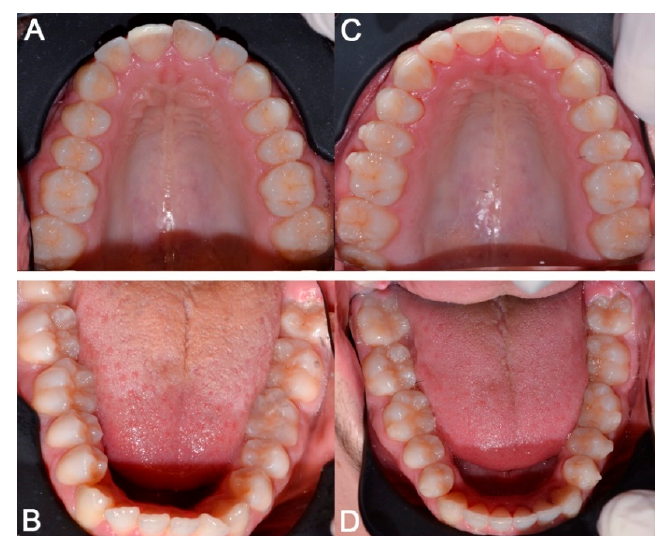
Figure 5. Case 1: initial ( A , B ) and final ( C , D ) superior and inferior occlusal arches photo.